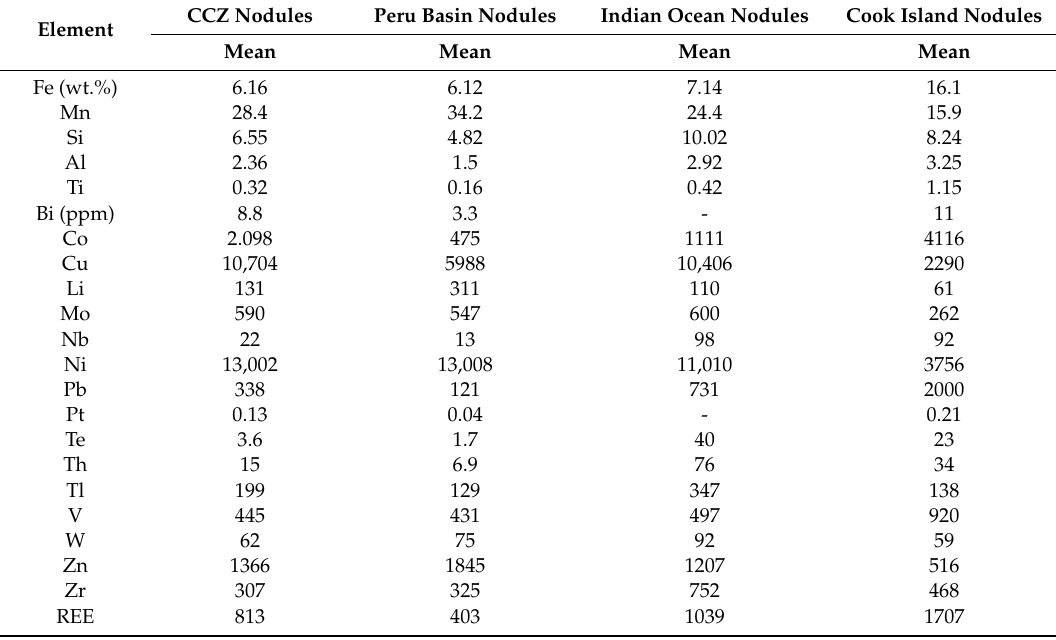
Table 1. Chemical composition of manganese nodules for the di ff erent oceanic areas of the world (modified from Hein